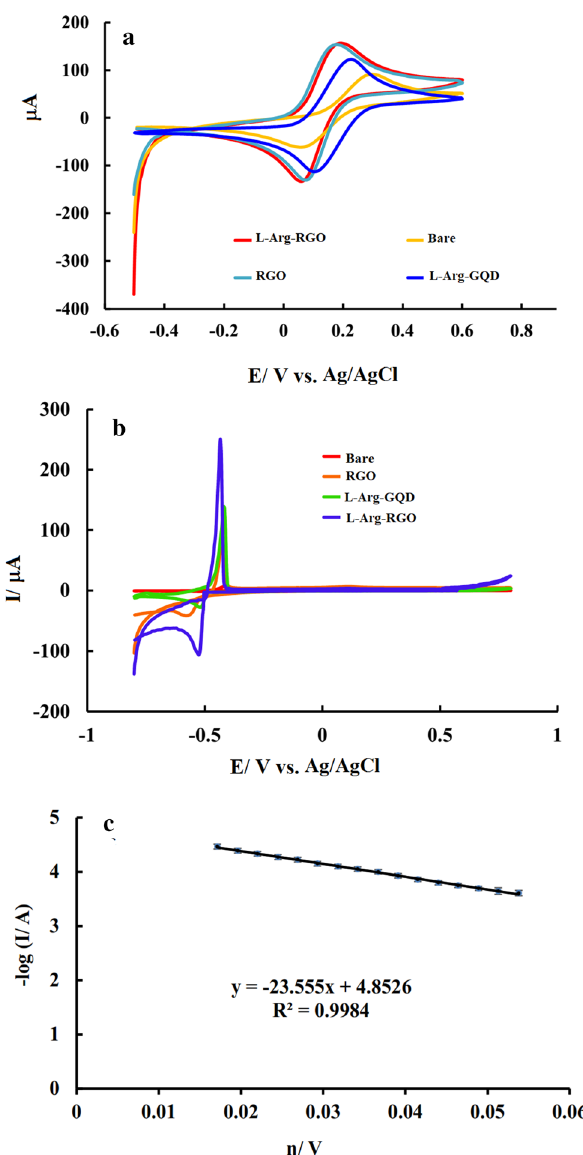
Figure 7. Cyclic voltammograms of bare, RGO, l-Arg-GQD, and l-Arg-RGO modified GCE in 5 mM /Fe ( CN ) 4 − Fe ( CN ) 3 − 6 solution containing 0.1 M KCl ( a ); Cyclic voltammograms of bare, RGO, l-Arg-GQD, 6 and l-Arg-RGO modified GCE recorded in Pb(II) free KCl solution with pH 6 after preconcentration applying − 0.8 V for 120 s to the electrodes immersed in 2.5 µM Pb(II) with pH 6 ( b ); Tafel plot for anodic branches of the current-overpotential curve obtained from oxidation peak of CV experiment related to l-Arg-RGO ( c ). Scan rate: 100 mV s −1